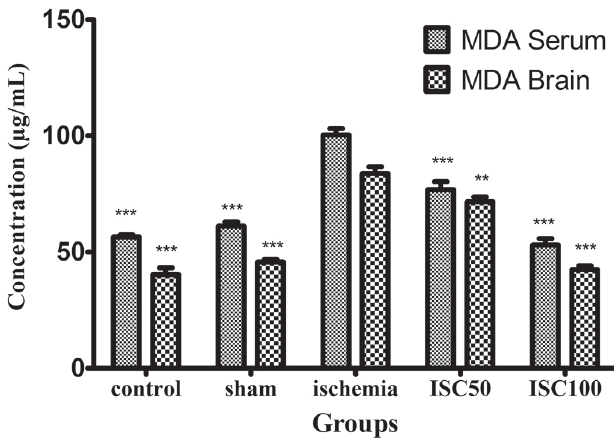
FIGURE 3 - The effect of A. italica extract on antioxidant capacity of serum and brain on hippocampal injury induced by transient global cerebral ischemia and reperfusion. ISC 100 and ISC 50: treated with 100 and 50 mg/kg of A. italica extract, respectively. (***: significant difference between the all groups with ischemia group, P<0.001). The number of samples, n=7.